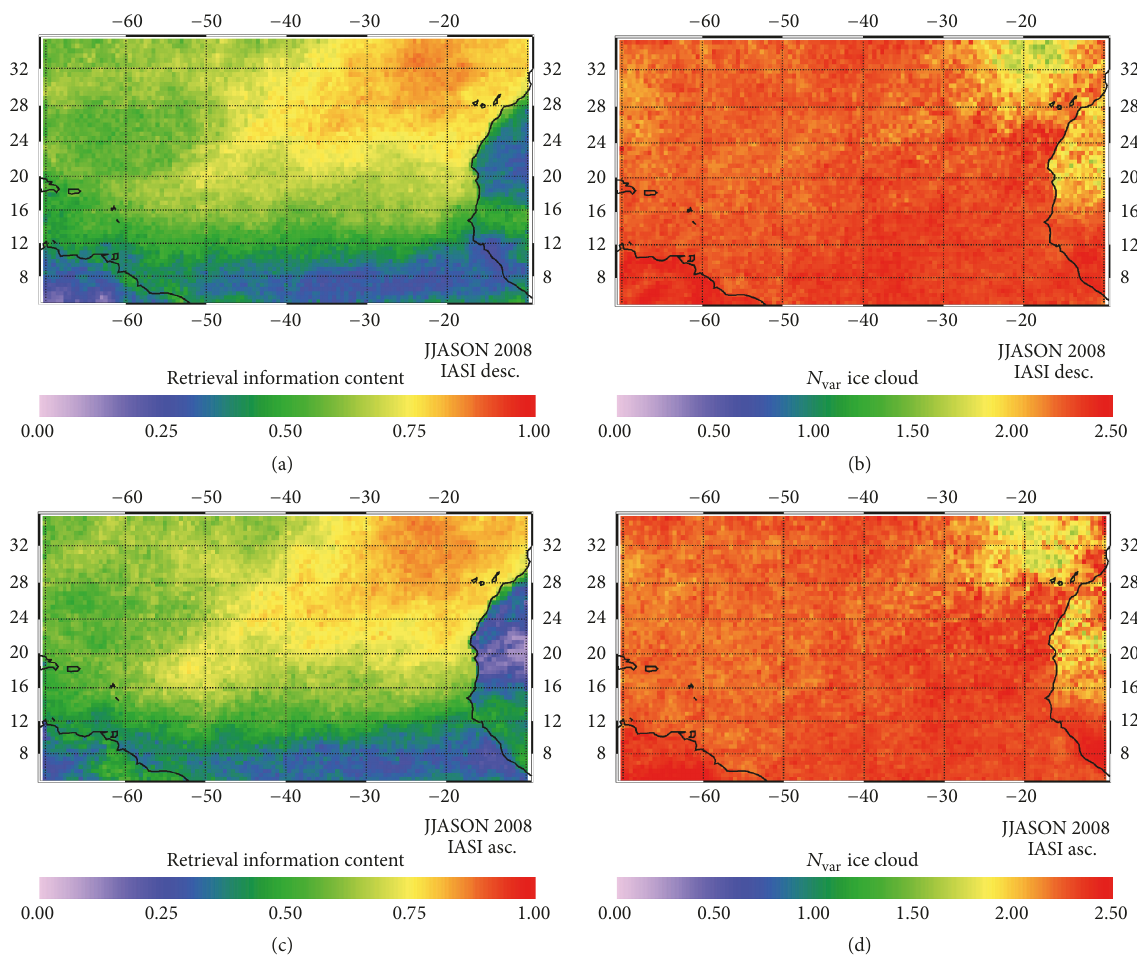
Figure 2: Average Shannon retrieval information content 𝐼 ret (a, c) and number of ice cloud independent variables 𝑁 var (b, d) as obtained from the IMARS retrieval for IASI descending (a, b) and ascending (c, d) overpasses for the hurricane season 2008 over the tropical North Atlantic